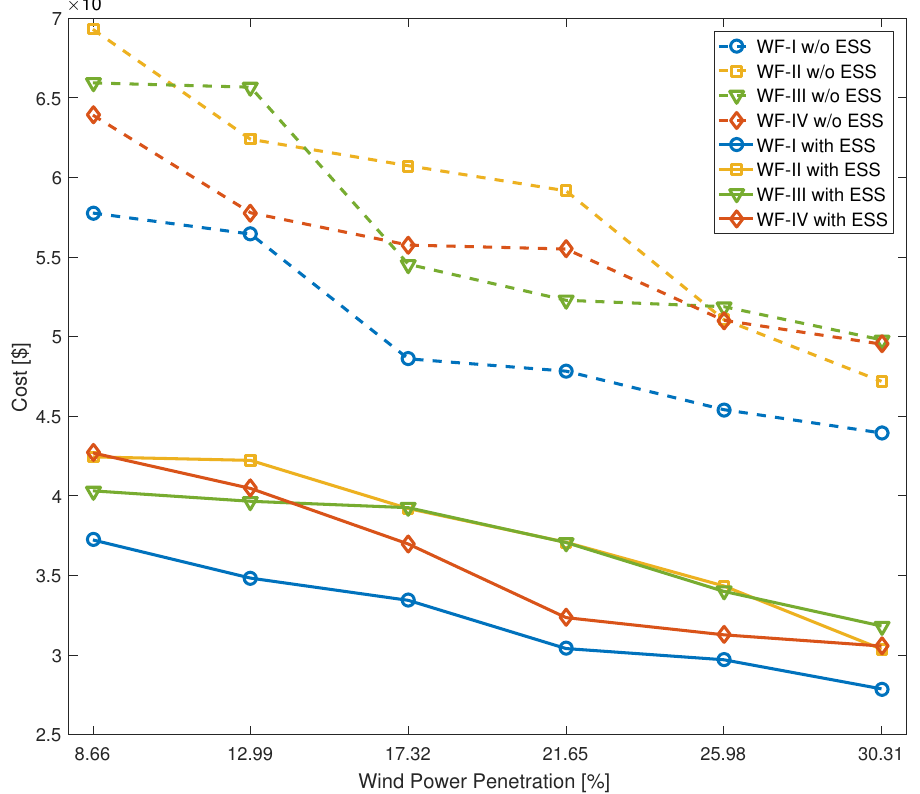
Figure 9. Operation costs comparisons with and without (w/o) the ESS of four W-ESS plants considering different wind power penetration levels.